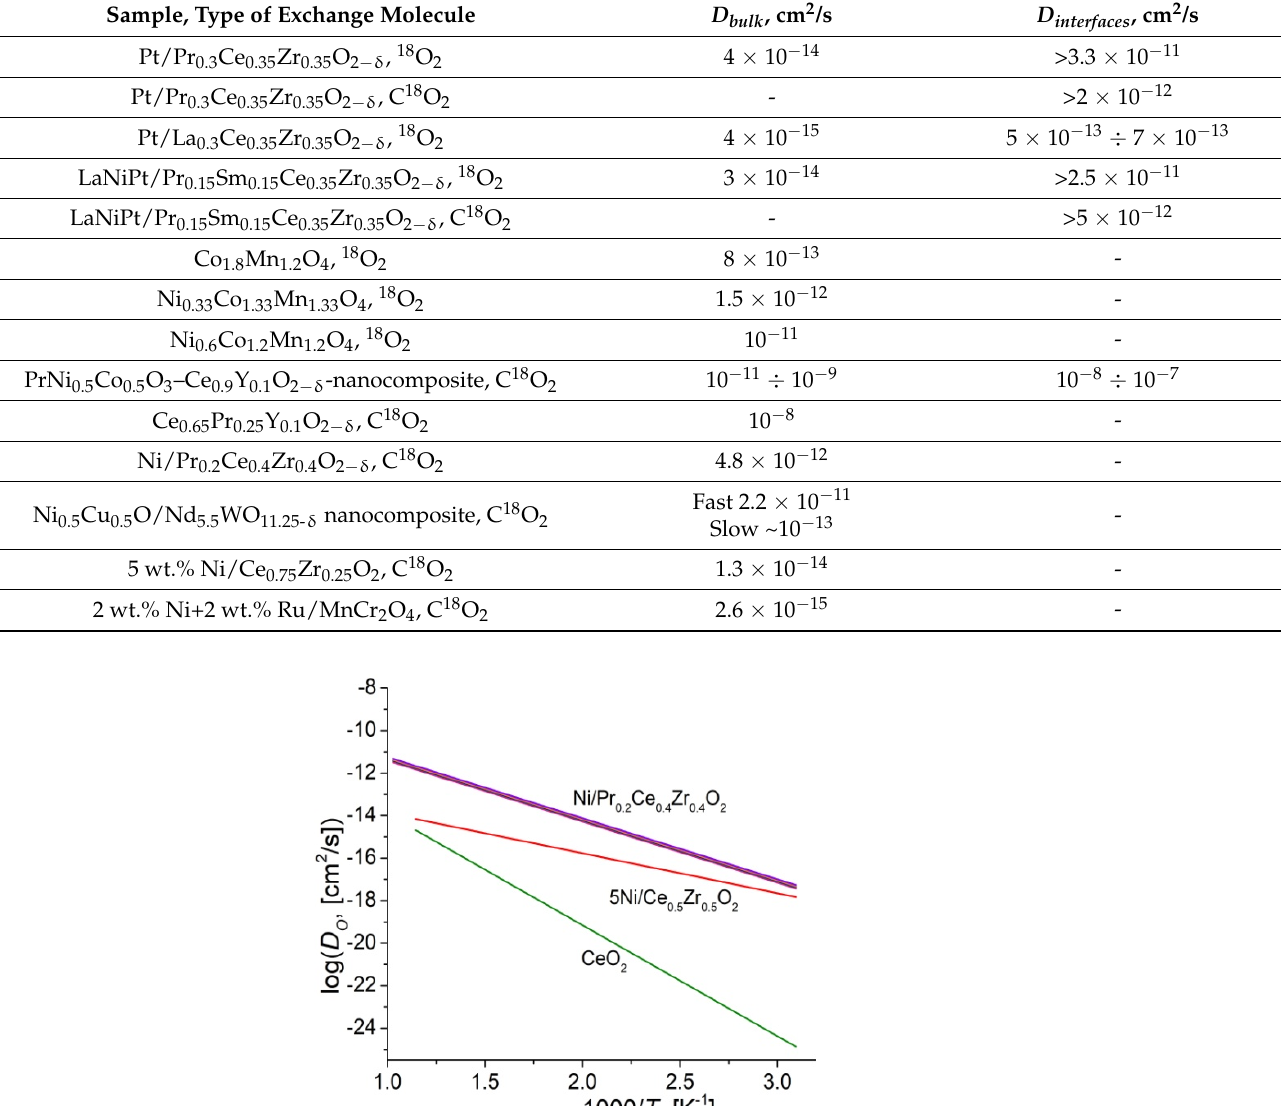
Table 1. Oxygen self-diffusion coefficients in the bulk ( D bulk ) and along grain boundaries ( D interface ) at 700 ◦ C [19,24,68,69,104–109]. Sample, Type of Exchange Molecule D bulk , cm 2 /s